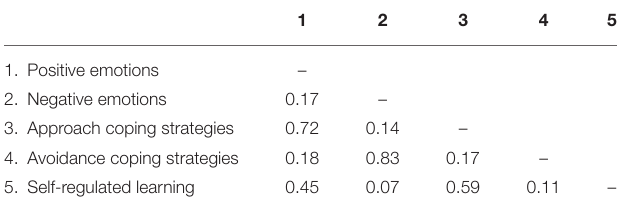
TABLE 4 | Heterotrait-Monotrait Ratio (HTMT) results.